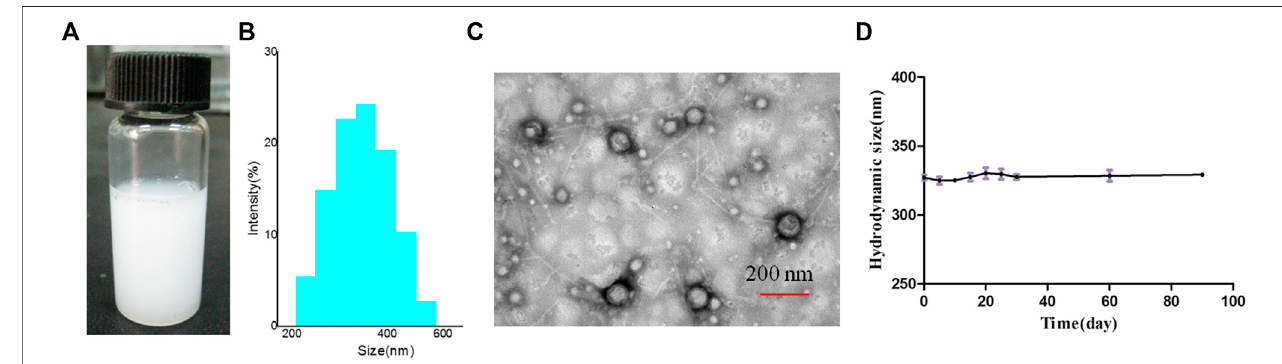
Figure 3 | Characterization of Lf – PLLA NBs. (A) Appearance, (B) size distribution, (C) TEM images, and (D) the stability of the NBs in vitro